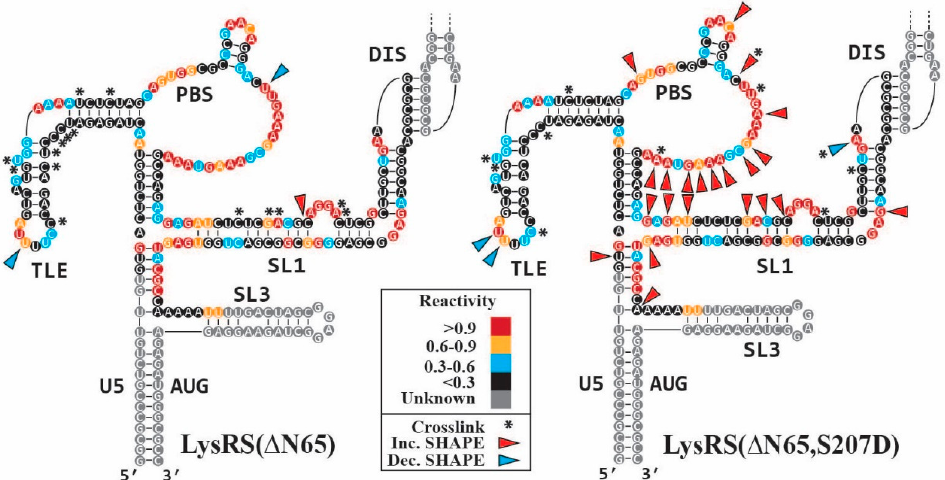
Figure 3. XL-SHAPE results for LysRS( ∆ N65) variants binding to WT UTR 240 . The baseline SHAPE reactivities are shown as colored circles behind each nt. Grey circles indicate the region of the structure that was not probed in our studies. SHAPE reactivity changes that occurred upon titration of WT LysRS( ∆ N65) (left) and S207D LysRS( ∆ N65) (right) are identified with colored arrows (red = increased reactivity, blue = decreased reactivity) and crosslinked sites are denoted with asterisks. Despite their similar binding affinity and XL footprints, a larger number of SHAPE reactivity changes resulted from S207D LysRS( Δ N65) binding when compared to WT LysRS( Δ N65) (25 and 3, respectively). Indeed, 22 of the 25 differences upon titration of S207D LysRS( Δ N65) are increases in SHAPE reactivity, located predominantly in the PBS loop and SL1 stem (Figure 3, red arrows), indicating an increase in the conformational flexibility of these regions. The binding of both proteins resulted in reduced flexibility (Figure 3, blue arrows) at the 3 ′ side of the TLE loop, likely because of protein binding. 3.4. The Monomeric UTR 240 ( Δ DIS) Adopts an Extended Cruciform-like Conformation The binding assays and XL data suggest that both LysRS( Δ N65) constructs directly bind the TLE and SL1 stems of the UTR 240 and do not interact directly with the DIS